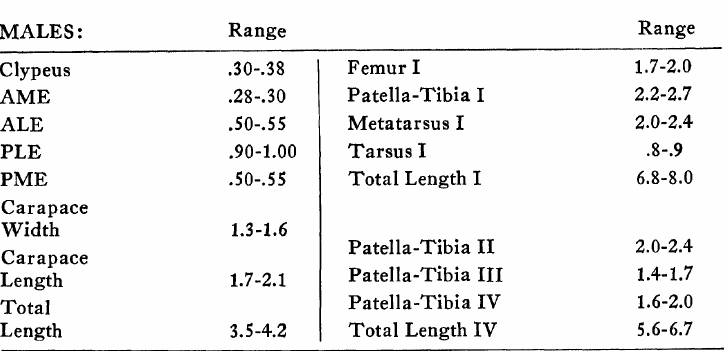
Color. Female. Face and chelicerae pale orange-yellow, lighter cream along lower edge .of clypeus. A pair of black lines from AME to subdistal region of chelicerae as in Figure 9. Eye nacelles black. stripes as in Figure